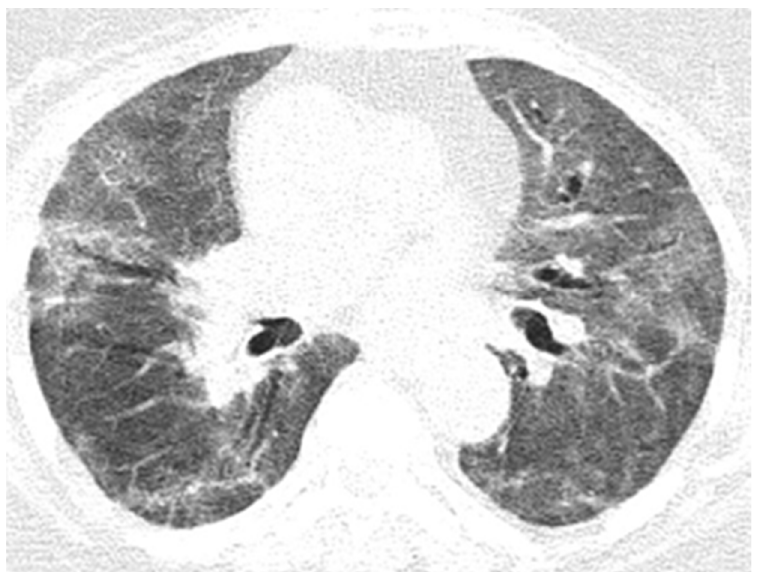
Figure 13. After 10 days, the thoraco-pulmonary CT of the Case 10 patient revealed that the previously described lesions are numerically and dimensionally stationary, at times reduced in intensity. In conclusion, pulmonary lesions of SARS-CoV-2 type in discrete remission, and were severely impaired.